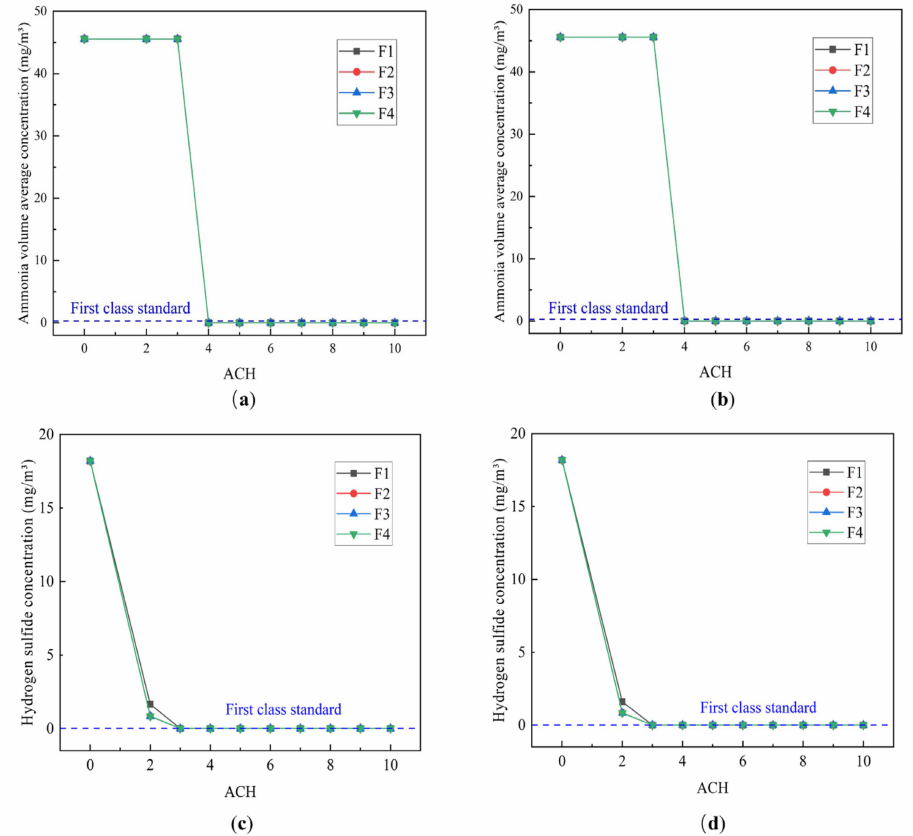
Figure 16. Average concentrations of ( a , b ) ammonia and ( c , d ) hydrogen sulfide in the B-Z for different ACH (unit: h − 1 ) values. ( a ): Z = 0.9 m, ( b ): Z = 1.5 m; ( c ): Z = 0.9 m, ( d ): Z = 1.5